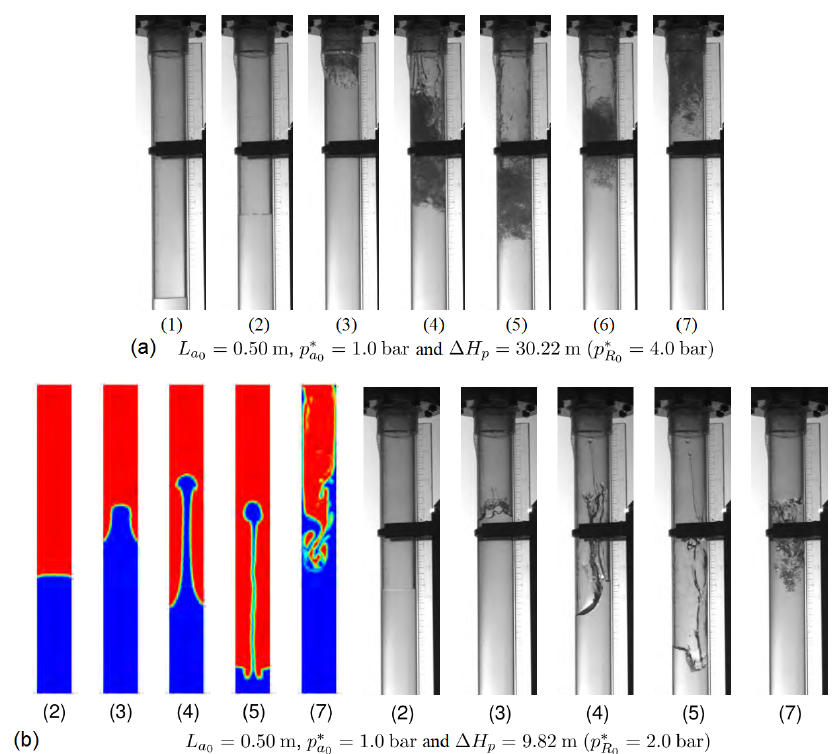
Figure 4. Behaviour of air–water interface in vertical pipe segment during pipeline filling: ( a ) interface showing intense air–water mixture; ( b ) comparison between numerical and experimental